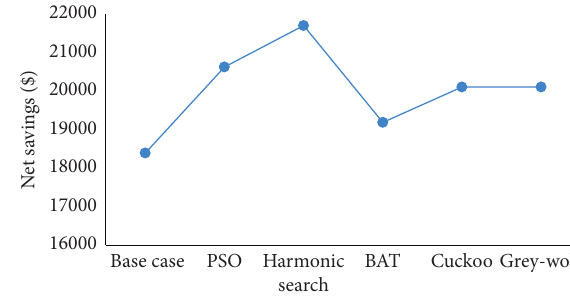
Figure 14: Net savings in different